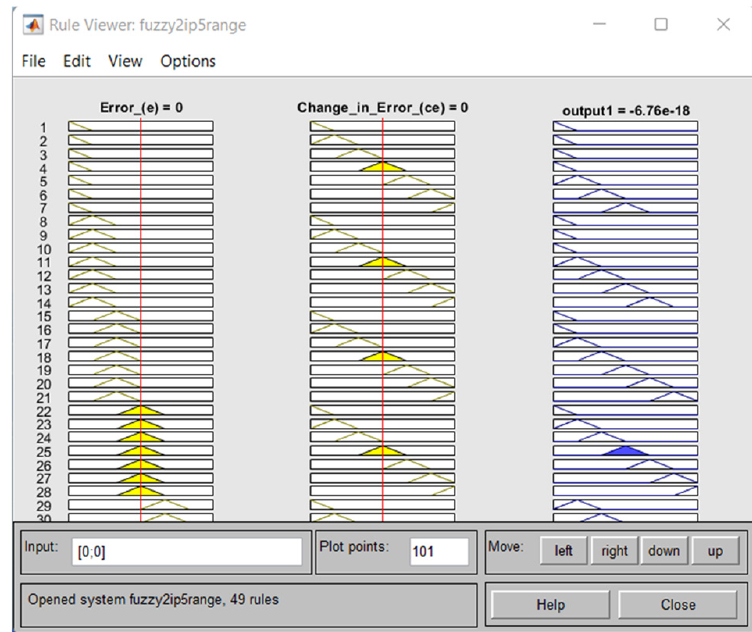
Figure 14. Designed fuzzy controller rules.